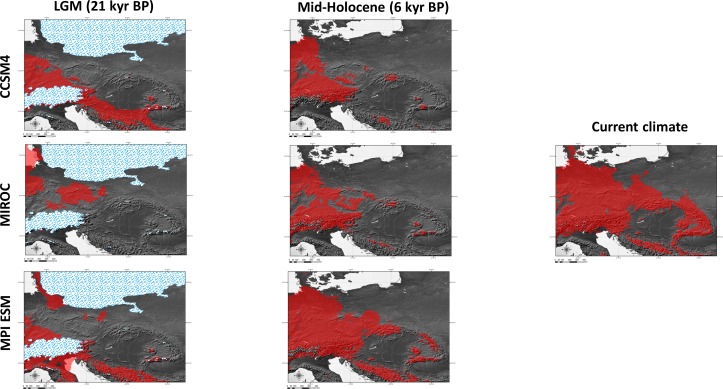
Results of modelling experiments.Binary maps of distributions based on the results of ensemble models (mean of probabilities) are shown. Results are based on the data from three different paleoclimate models: CCSM4, MIROC and MPI ESM, as well as current climate observations. Species range was reconstructed for two time periods: Last Glacial Maximum (LGM, ca. 21 kyr BP) and Mid-Holocene (ca. 6 kyr BP).